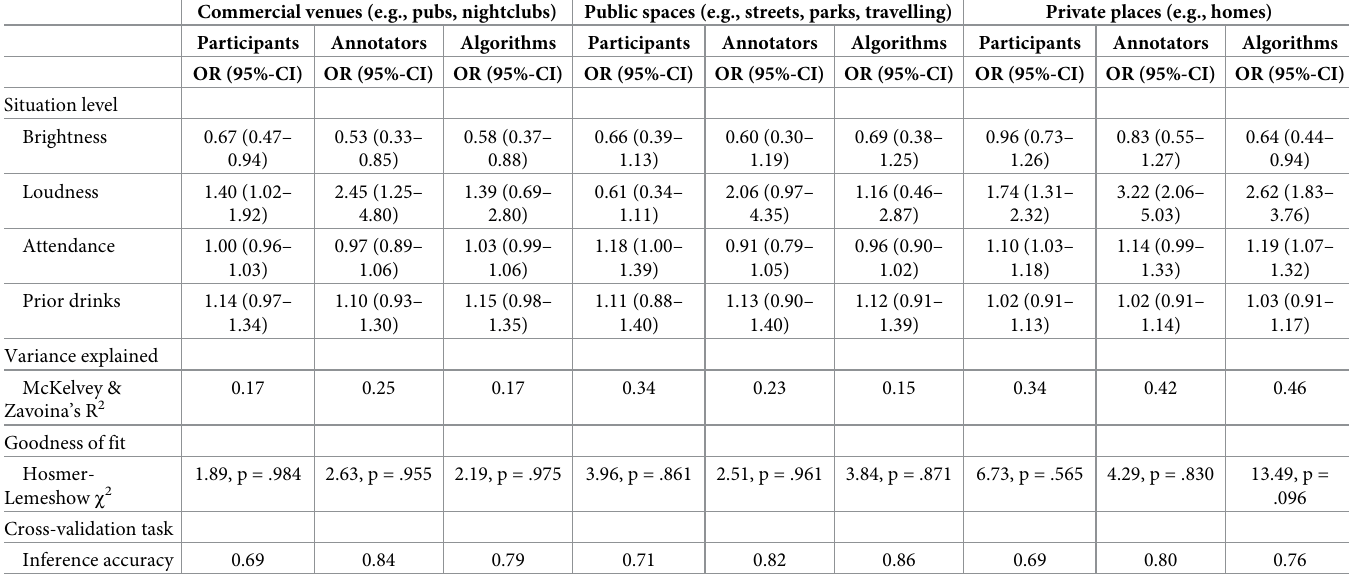
Table 3. Multivariate associations of contextual characteristics with the likelihood of consuming alcoholic drinks in different settings, separately per data source, and models performance indices. Commercial venues (e.g., pubs,